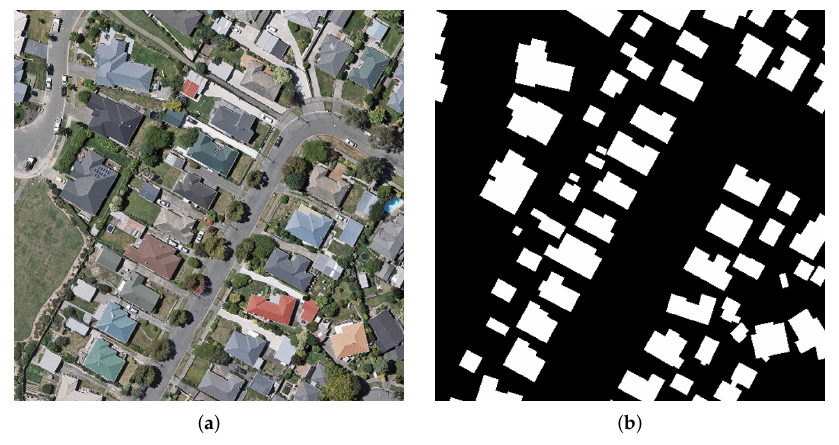
Figure 8. An example of the WHU dataset. ( a ) Original image; ( b ) Ground truth